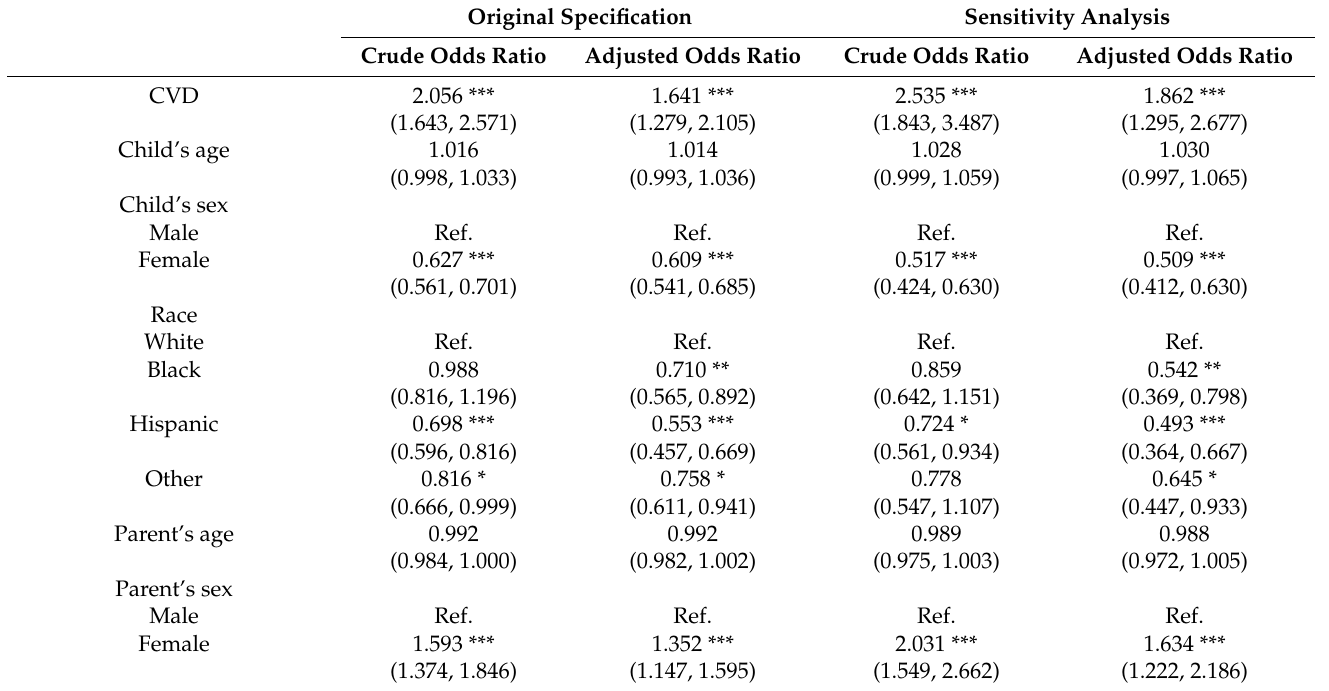
Table 3. Crude and adjusted odds ratios in favor of difficulties in emotions, concentration, behavior, or being able to get along with other